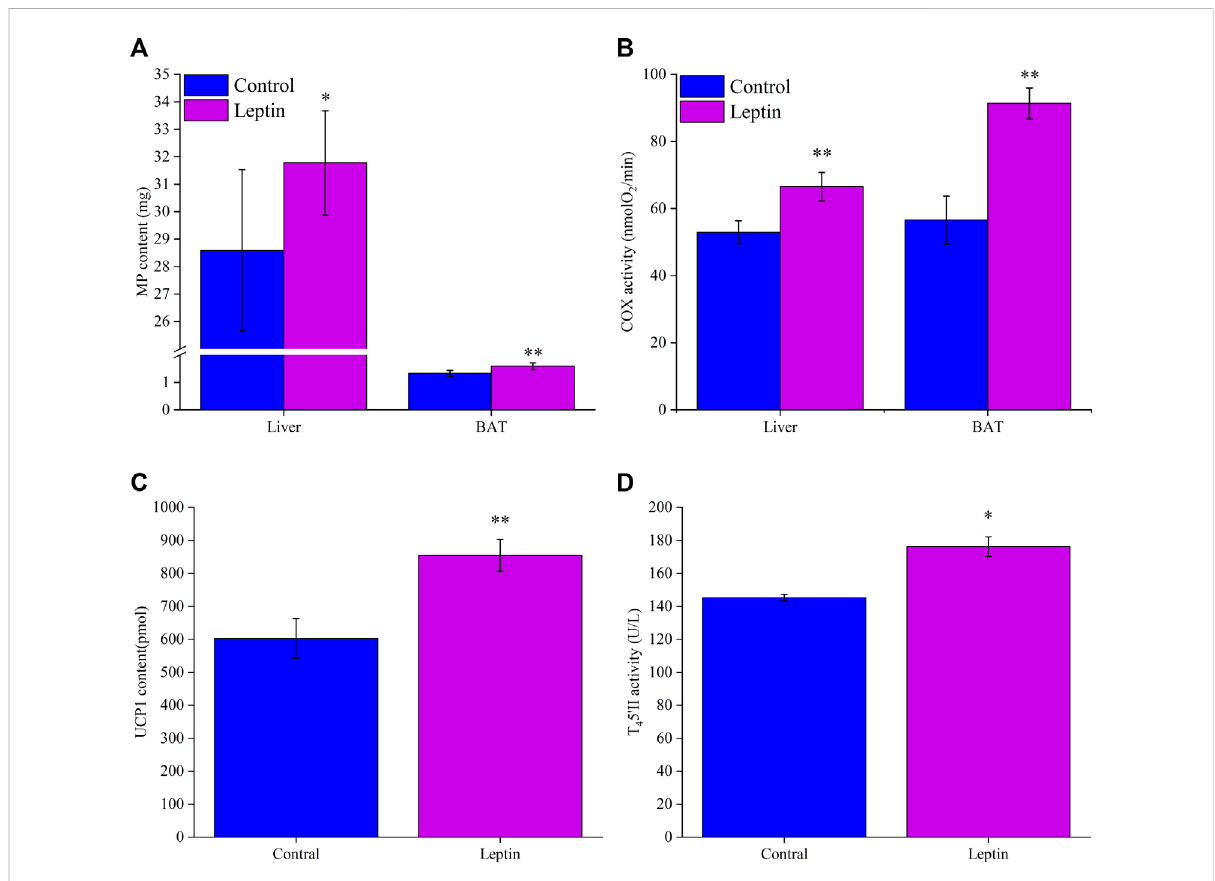
FIGURE 3 Leptin affects mitochondrial protein content (A) and COX activity (B) of Eothenomys miletus in liver and BAT, UCP1 content (C) and T 4 5 ′ -DII activity (D) in BAT. *: p < .05, **: p < .01 indicates a signi fi cant difference between the leptin and control